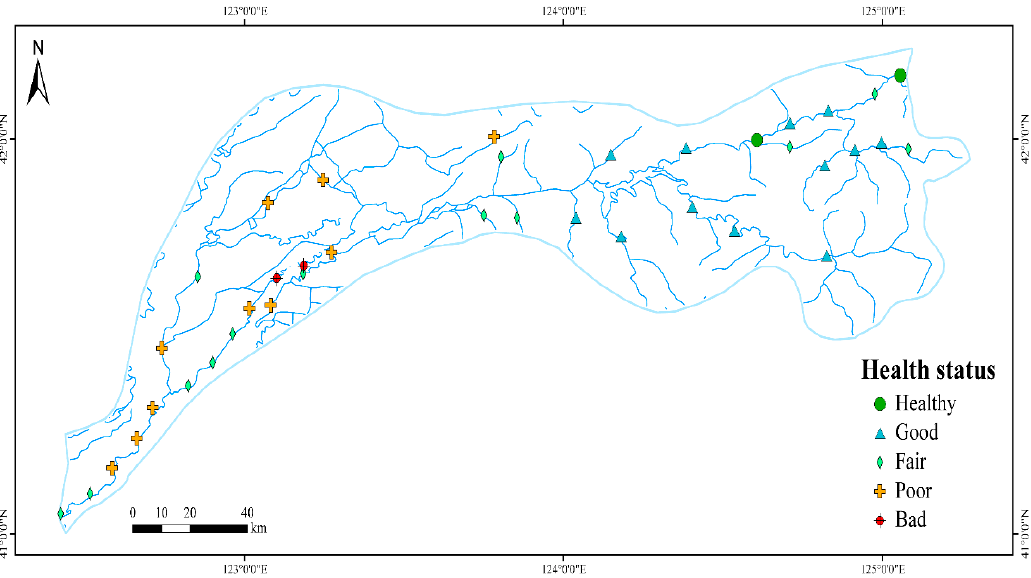
Figure 9. Spatial distribution based on the fish biological integrity index (F-IBI) health assessment levels.